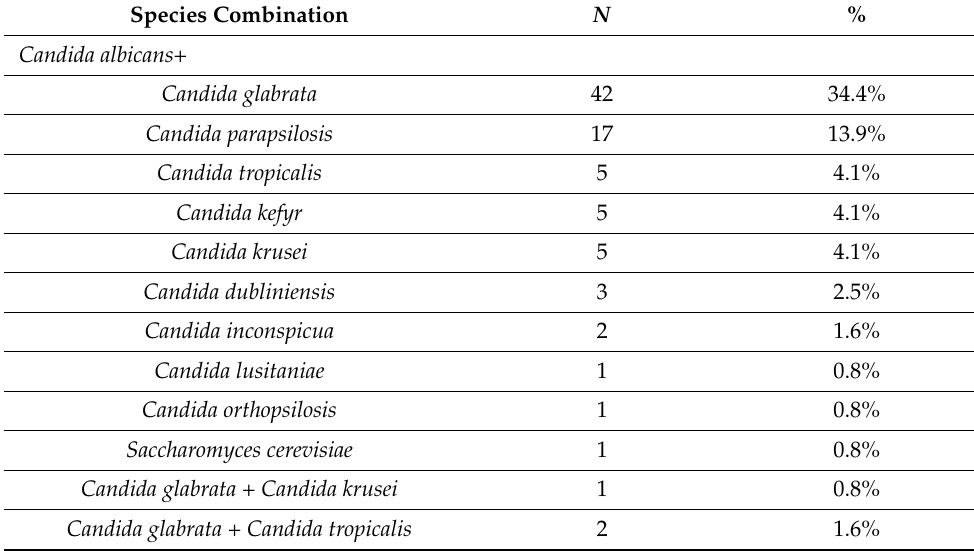
Table 3. Species combinations of 122 MY